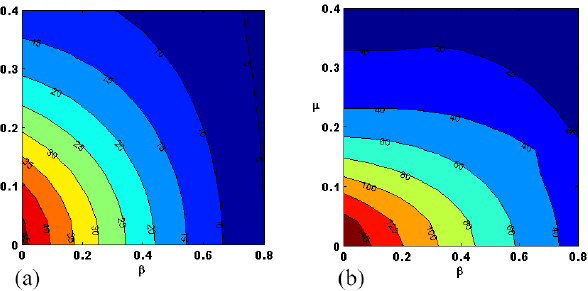
Figure 6. Contour plot of q 1 with respect to p and β with µ = 0 . 1,